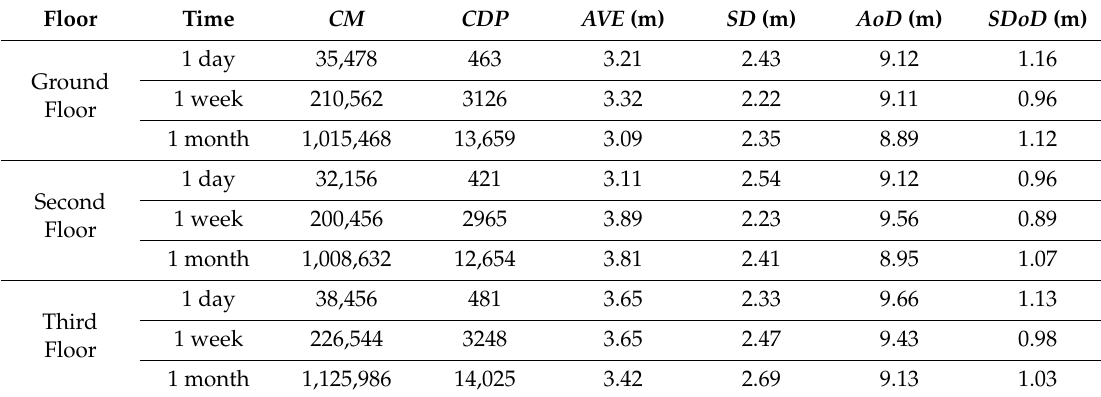
Table 1. Detailed statistical results of the indoor positioning